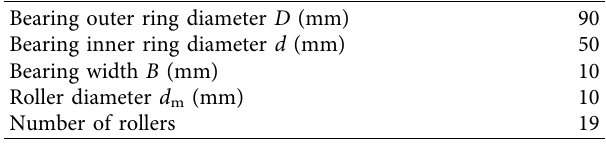
Table 1: Geometric parameters of the cylindrical roller bearing. Table 2: Material parameters of the cylindrical roller